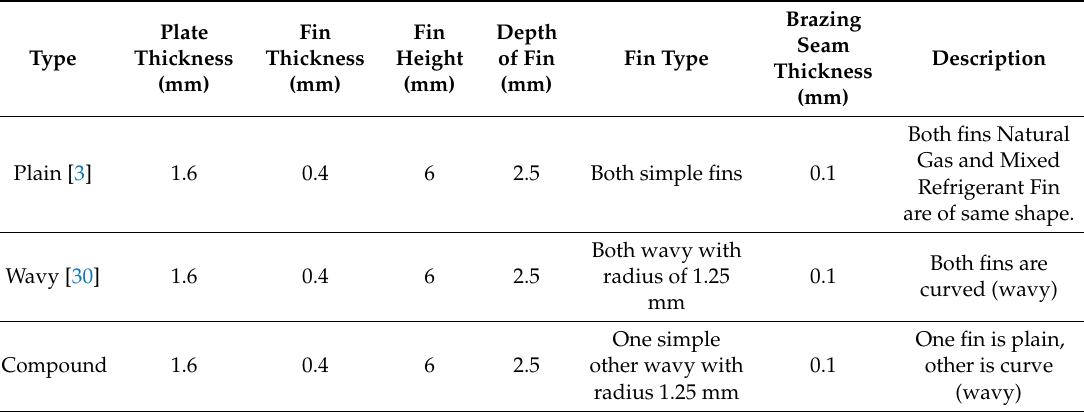
Table 1. Dimension of three fins used.